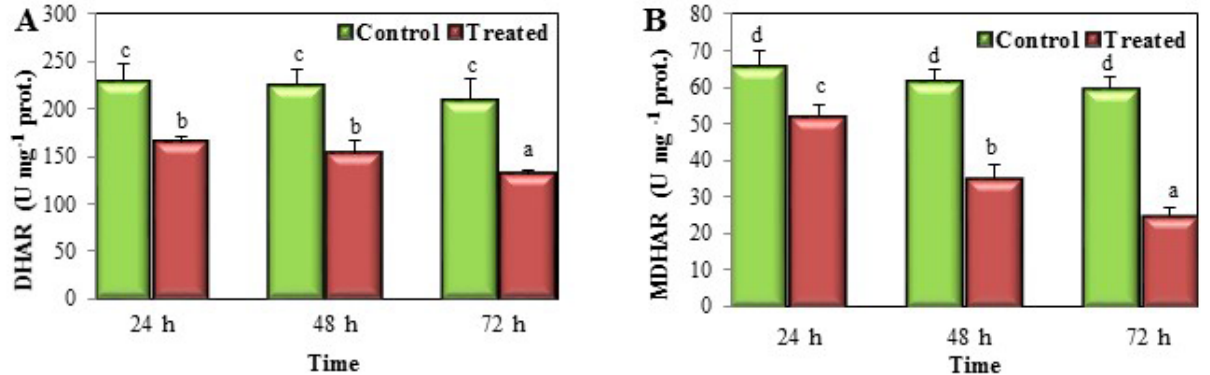
Figure 4. Changes in enzymes of ASC reconversion, namely dehydroascorbate reductase -DHAR- (A) and monodehy- droascorbate reductase –MDHAR- (B), in treated and untreated Chenopodium album leaf tissue during the time course. Data are mean values ± SD of four experiments. Bars with different letters were significantly different ( P <0.05) from each other. For DHAR, 1 U = 1 nmol of dehydroascorbate (DHA) reduced min −1 ; for MDHAR, 1U = 1 nmol of NADH oxidized min −1